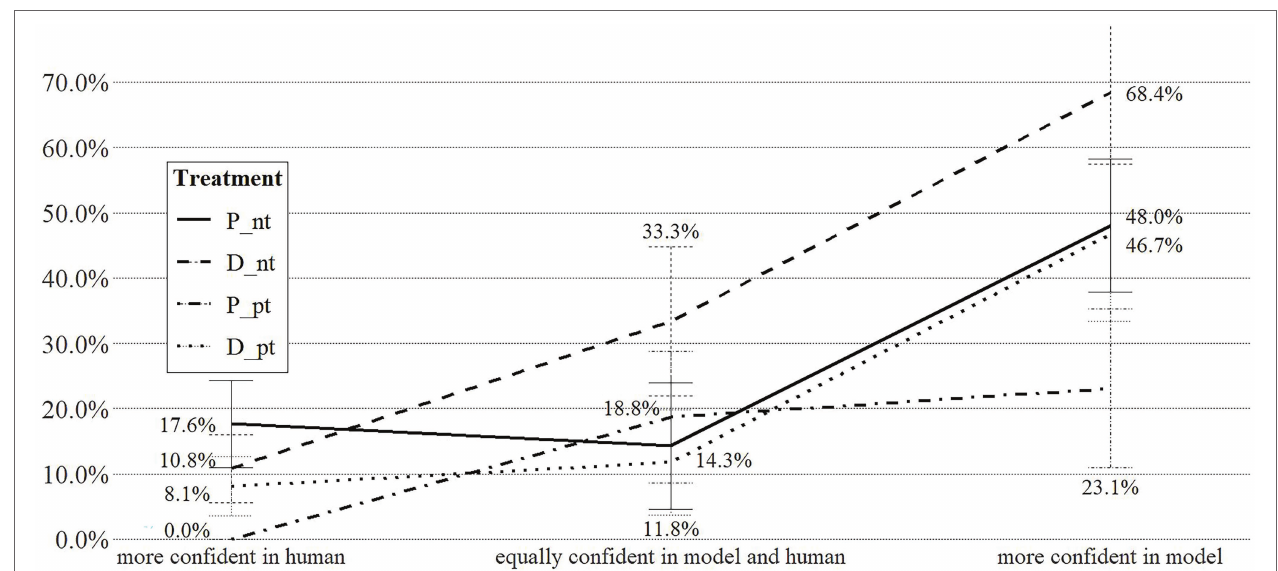
FIGURE 4 | Share (S) of participants delegating HR decision to algorithm, by treatment and confidence